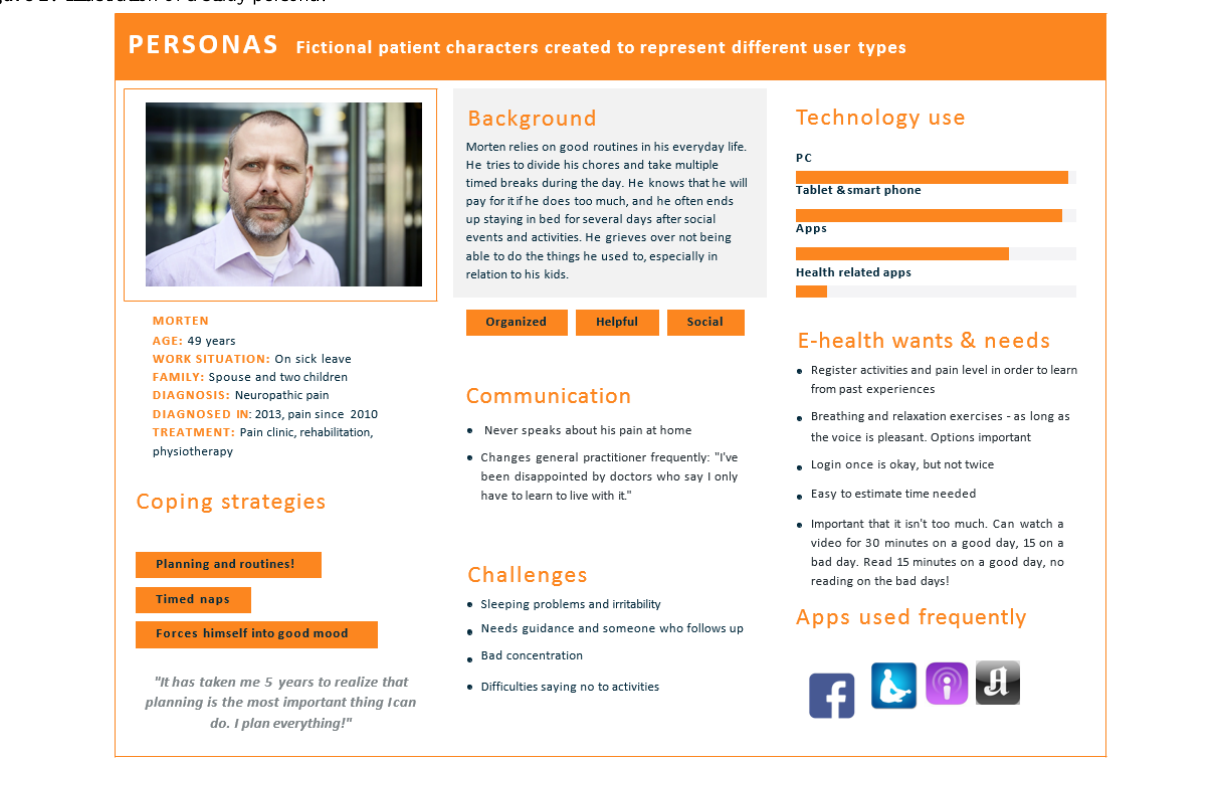
Figure 2. Illustration of a study persona.